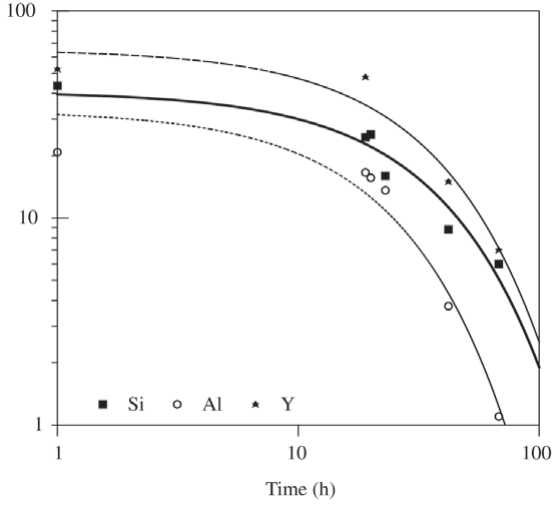
N sample exposed for 100 h to 1n 3 4